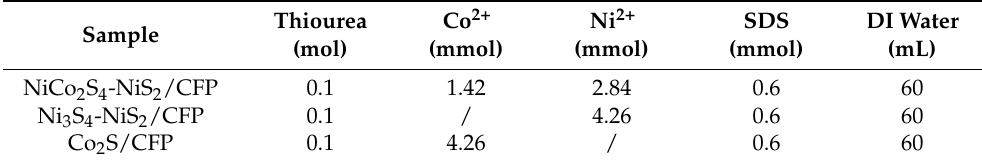
Table 1. The synthesis of four kinds of